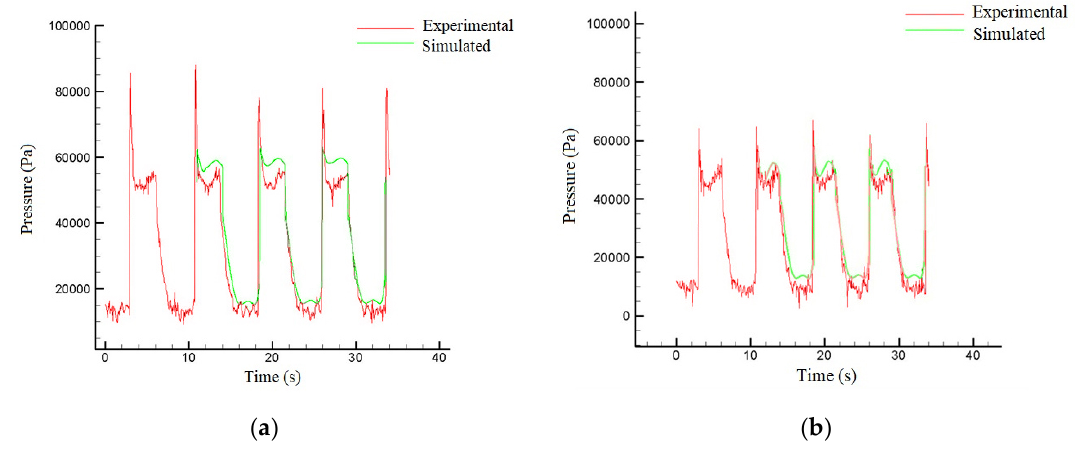
Figure 4. The comparison between the simulated and experimental results at the first and second pressure test points in one period: ( a ) the first pressure test point; ( b ) the second pressure test point.